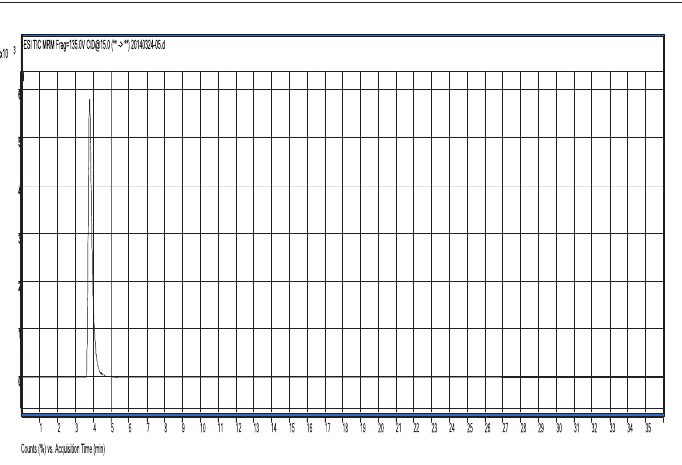
Fig. 5. Chromatogram of glutamate acid with triple quadrupole LC